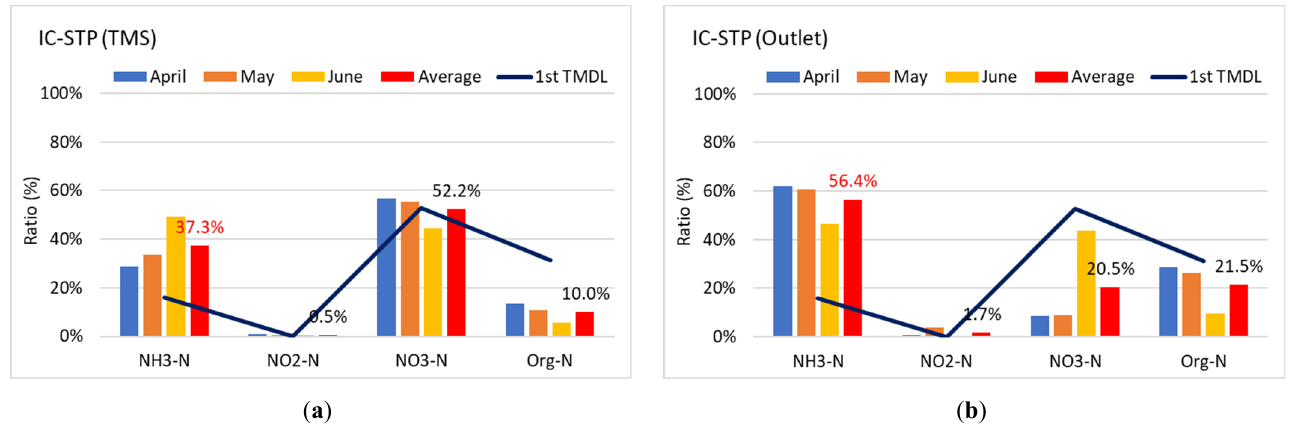
Figure 8. Nitrogen ratio by type surveyed at the IC-STP: ( a ) water quality in the TMS site; ( b ) wa- ter quality at the point where the effluent is discharged to the river.